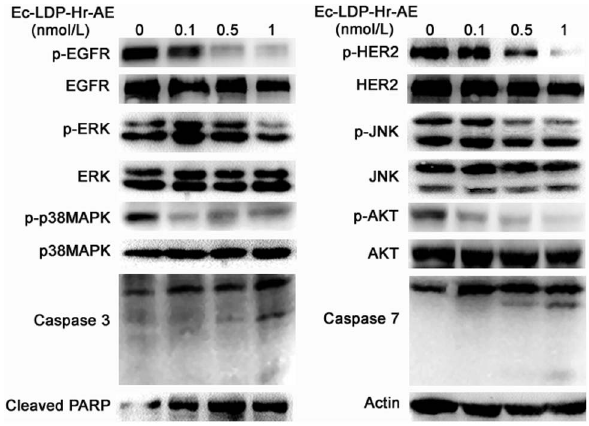
Figure 5. Effects of Ec-LDP-Hr-AE on the EGFR/HER2 signaling. The expression of apoptosis related molecules (e.g. Caspase 3, Caspase 7 and PARP) and key molecules in the EGFR/HER2 signaling pathways (e.g. phosphorylated-EGFR, -HER2, -ERK, -p38MAPK, -JNK, -AKT) were determined by Western blot analysis. b -actin was served as a loading control.